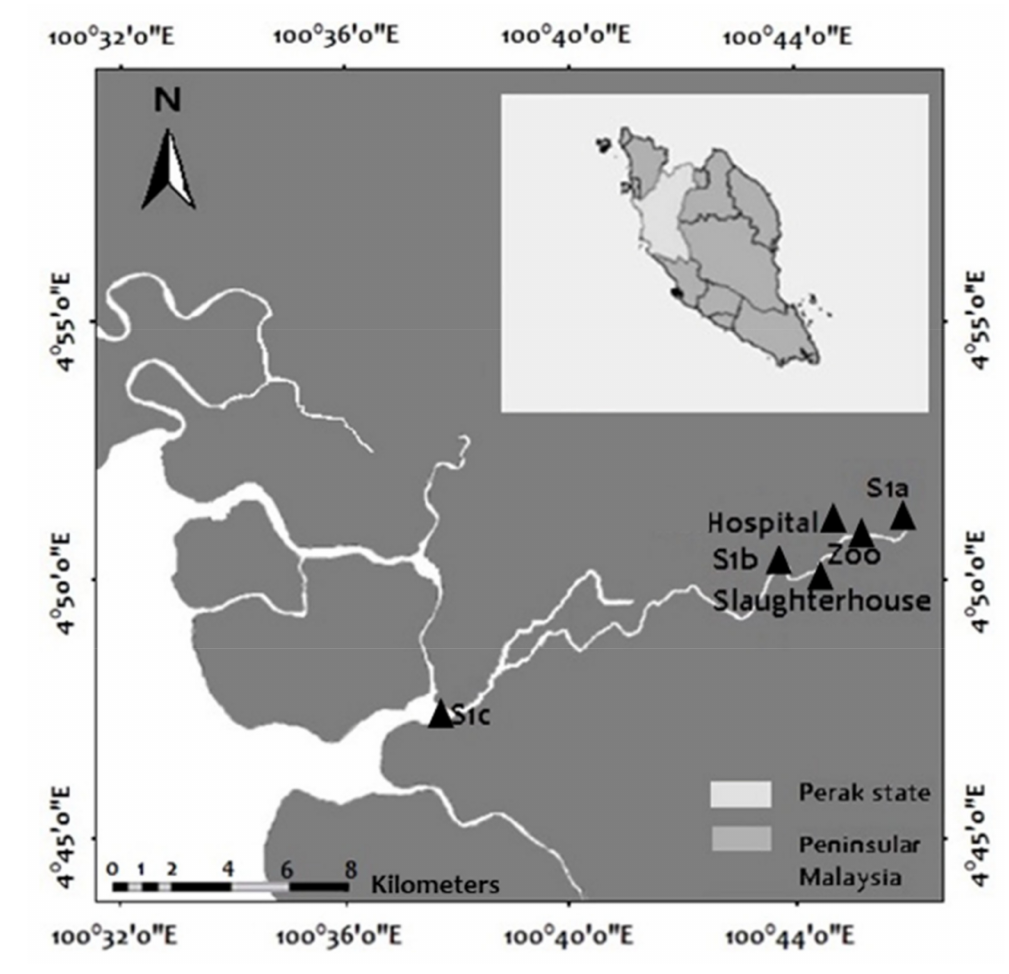
Figure 1. Sampling sites